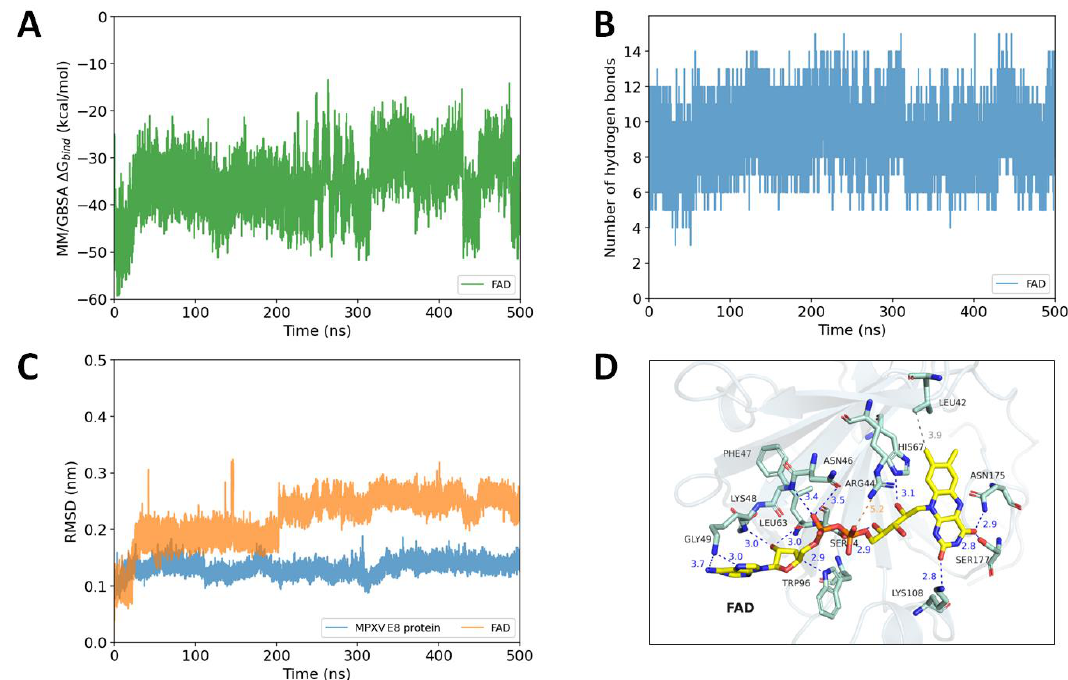
Figure 8. Binding features of FAD during 500 ns molecular dynamics simulation: ( A ) The MM/GBSA binding free energy of FAD during the simulation. ( B ) The number of hydrogen bonds occurred between FAD and the MPXV E8 protein. ( C ) The RMSD values of the MPXV E8 protein (in blue) and the RMSD values of FAD heavy atoms (in orange). ( D ) The representative pose of FAD in the last 10 nanoseconds of the simulation (hydrogen bonds are shown as blue, salt bridge is shown as orange, and hydrophobic interactions are shown as grey).